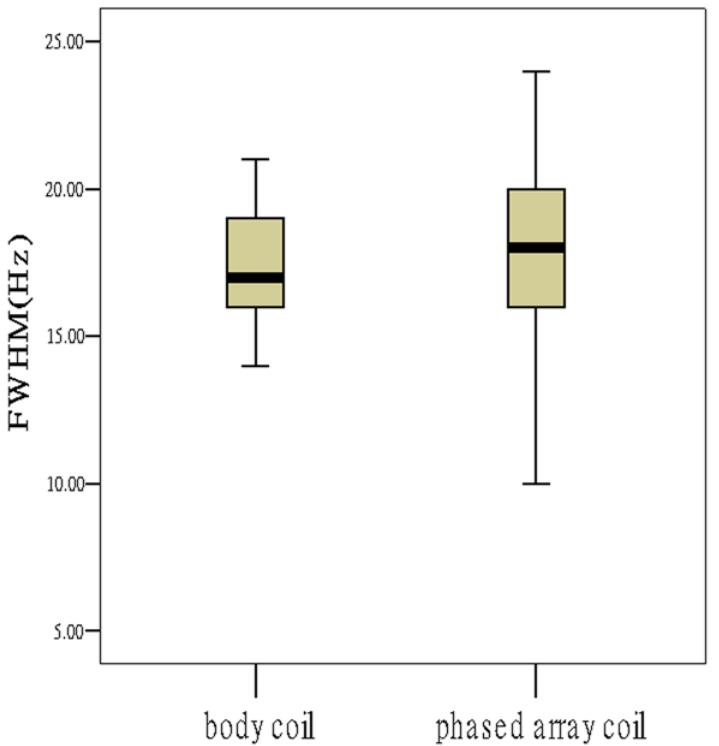
Fig 4. The phased array group had slightly worse shimming